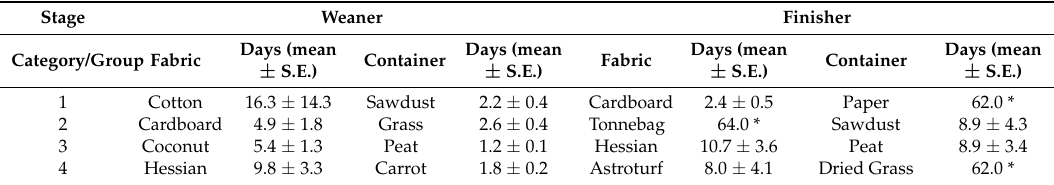
Table 4. The descriptive replacement rate for the fabric and loose material provided in the container in two different stages among the SAME